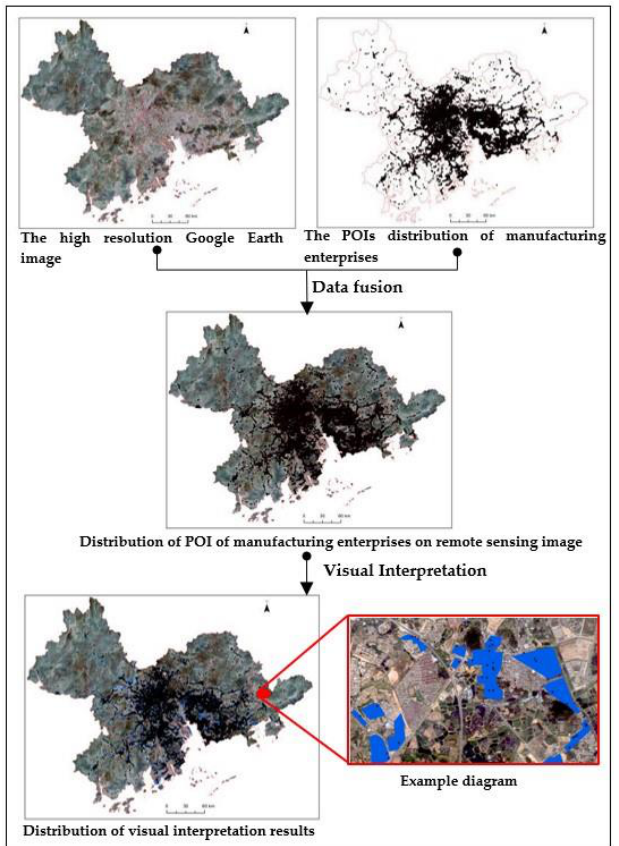
Figure 2. Technique flowchart of the interpretation of manufacturing production spaces in